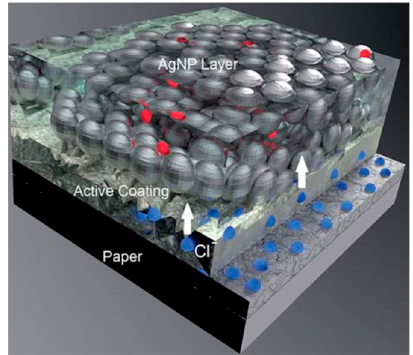
Figure 4. Schematic image showing the principle of the active papers. A small amount of chloride is contained in the coating as a sintering agent. During the deposition of the Ag NPs dispersion and absorption of the carrier fluid, Cl ions migrate into the Ag NPs film and react with the Ag NPs matrix to assist the sintering. Reproduced with permission from [73]; Copyright 2015 Royal Society of